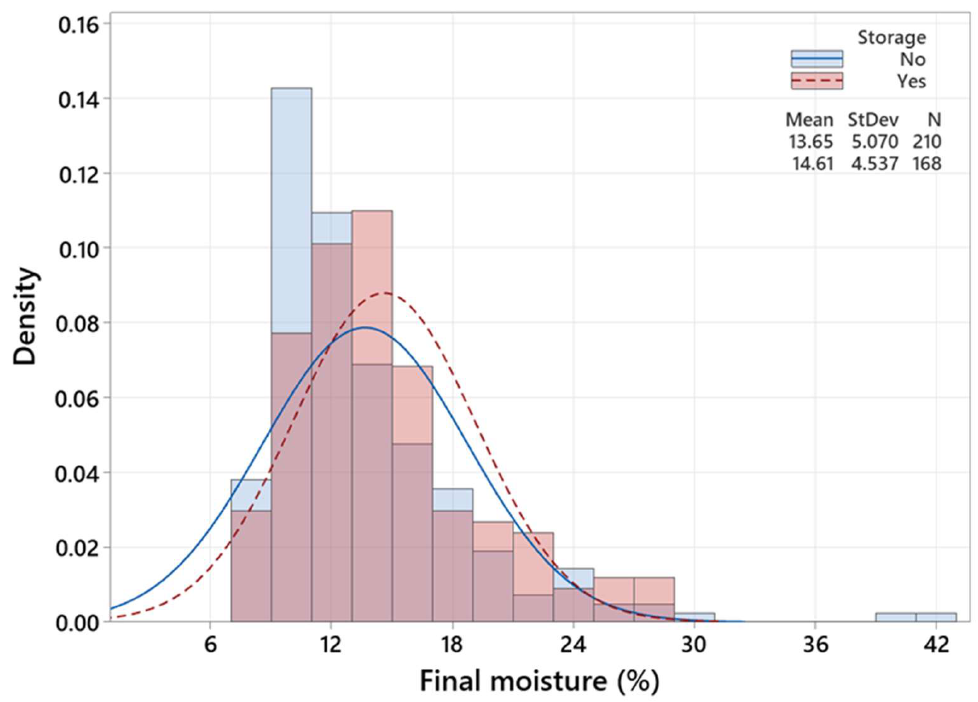
Figure 6. Histogram and distribution curves of the M f in the existence and nonexistence of the post- storage treatment.